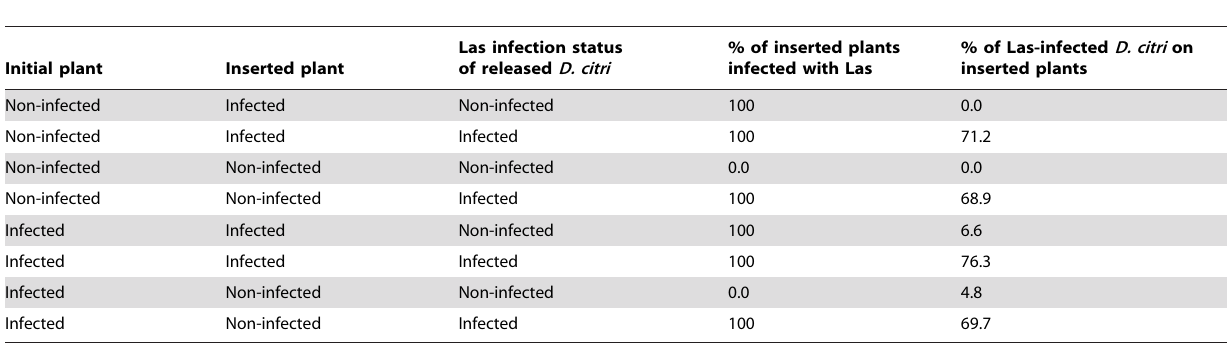
Table 1. Las infection status of inserted plants and Diaphorina citri migrating from initial point of forced settling to subsequently inserted plant treatments.